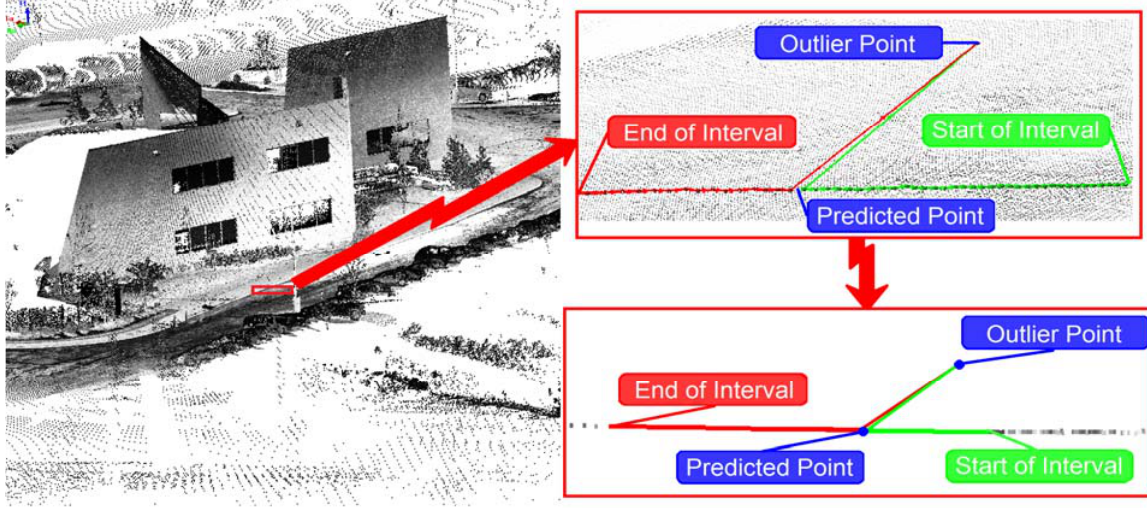
Figure 8. The moving fixed interval smoothing method applied to a section of a mobile terrestrial LiDAR point cloud collected with the Lynx Mobile